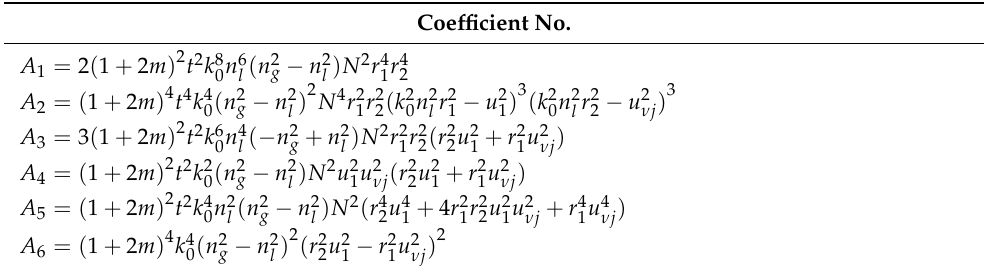
Table 2. Coefficients of the inequality